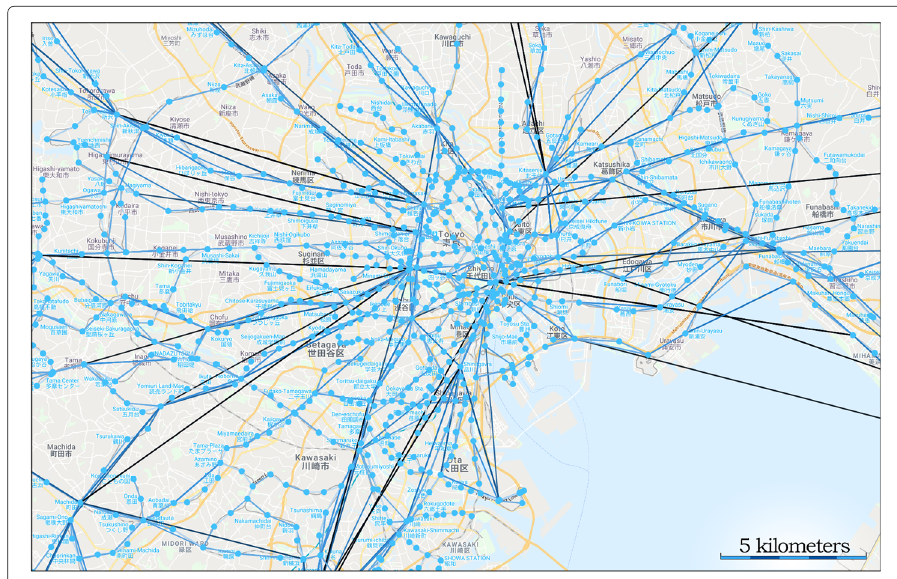
Fig. 3 Sample of the Tokyo Area train network showing lines of different types (local, rapid, express, etc.) connecting stations at different distances. Edges become darker with longer traversal times. Although station nodes are distinct from platform nodes in our construction, they share identical latitude and longitude coordinates, so they are co-located on this map